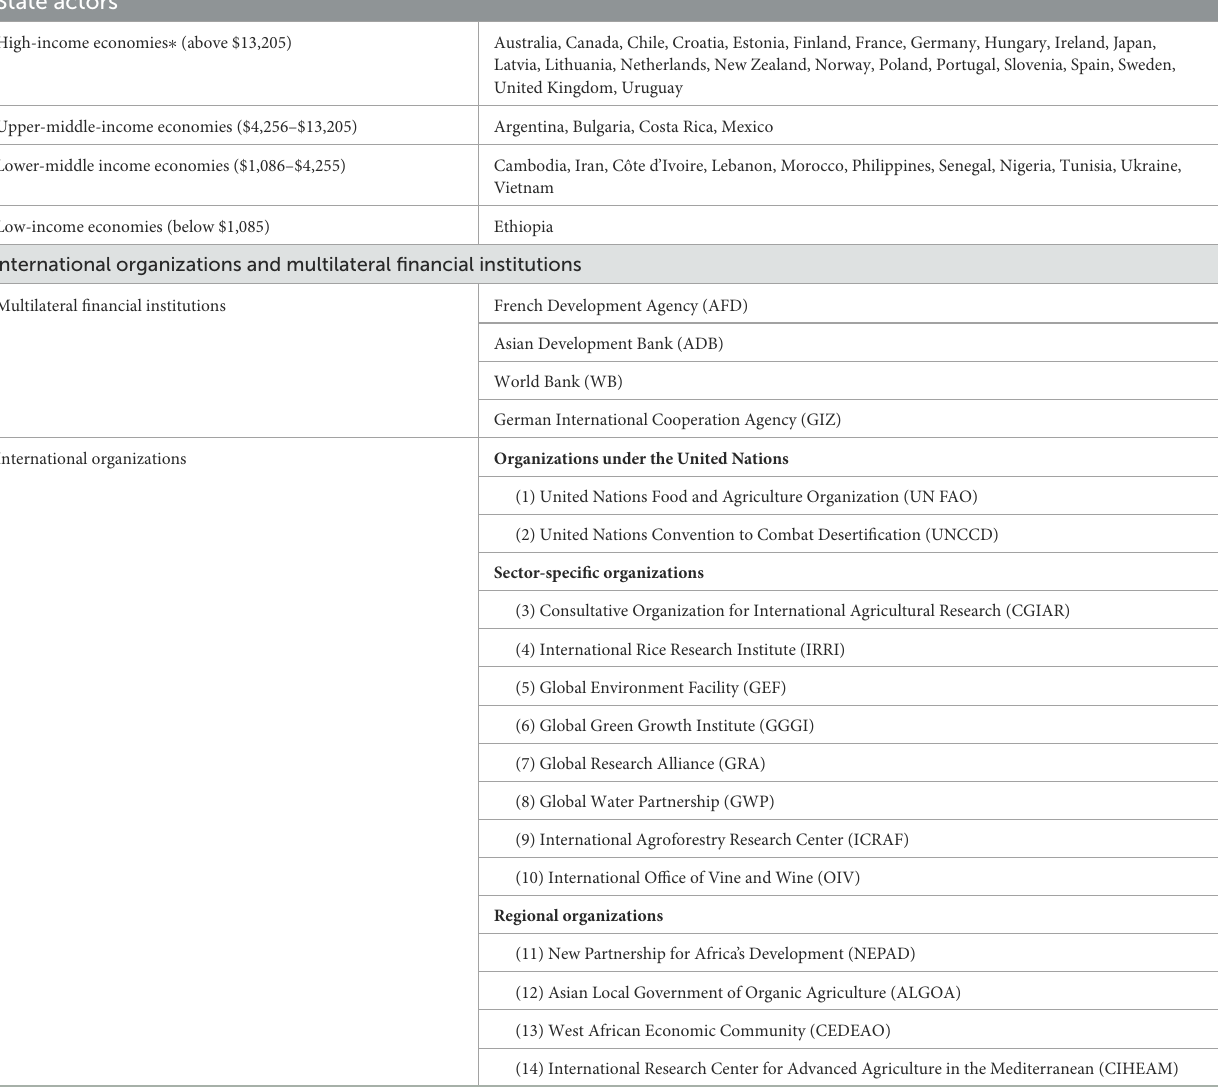
TABLE 1 State and international organization parties signing the “4 per 1,000” initiative. State